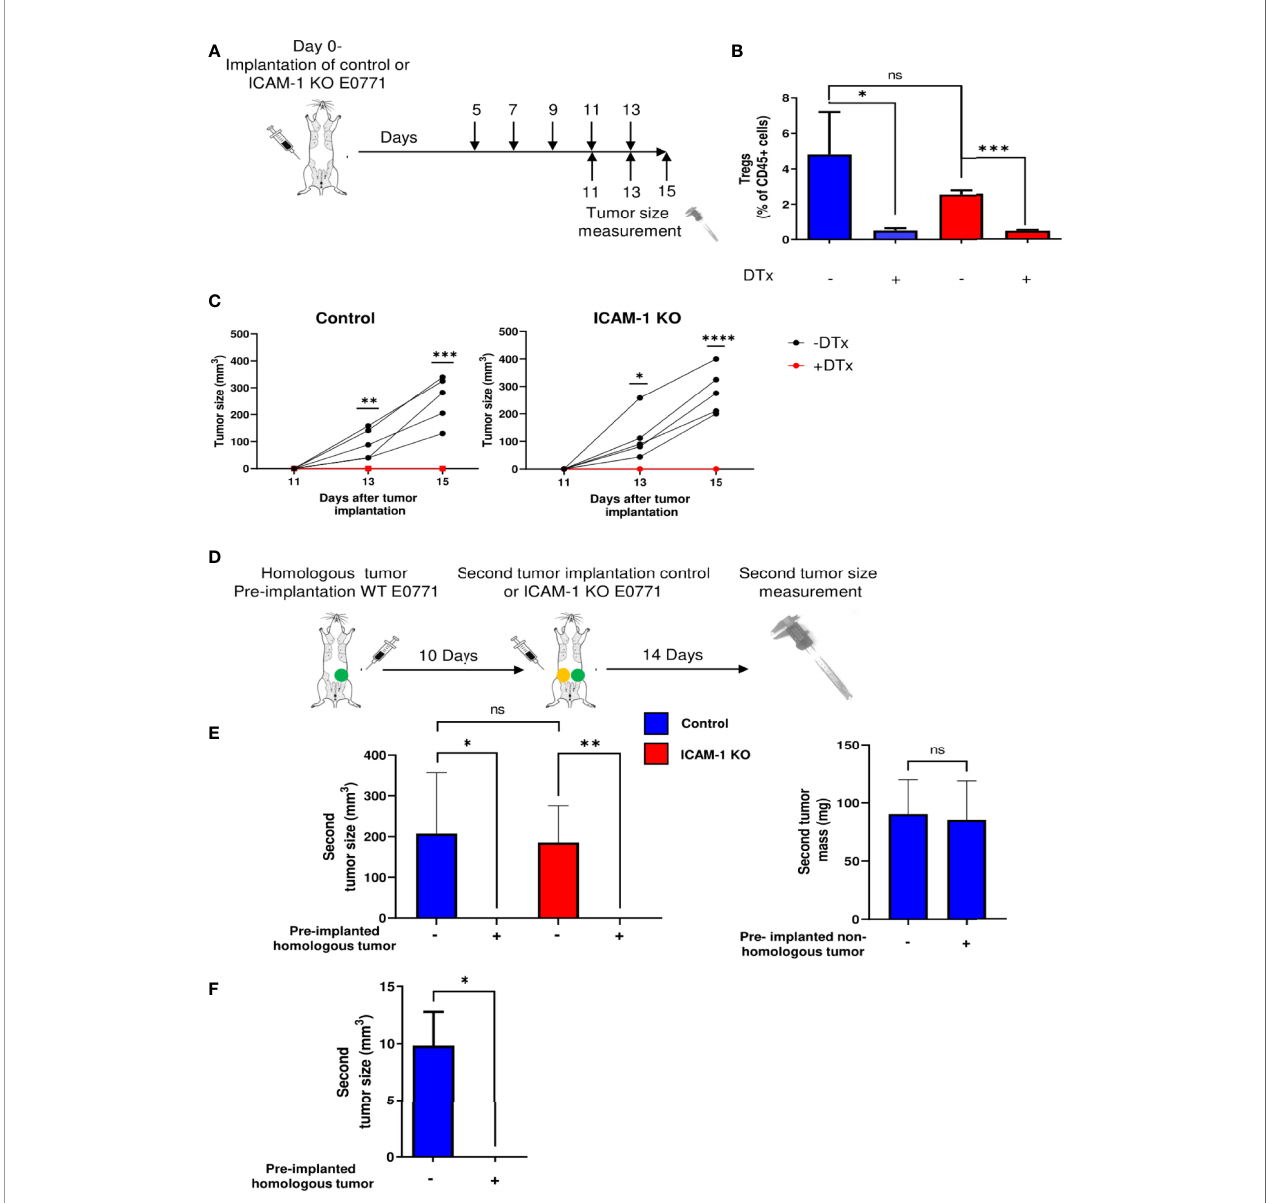
FIGURE 2 | Treg depletion and homologous tumor preimplantation eliminate primary E0771 tumors independently of ICAM-1 expression on the breast cancer cells. (A) A scheme depicting the experiment. 1 × 10 3 control or ICAM-1 KO E0771 cells were implanted in the mammary fat pad of C57BL/6 mice. DTx was injected every 2 days at the indicated time points, and the tumor size was measured on the indicated days. (B) Treg depletion by DTx injections was validated on day 17 in the TdLNs of mice implanted with control or the ICAM-1 KO E0771 cells. n=3. * p <0.05; *** p <0.0005; (C) The graphs depict the tumor size in the differently treated mice at the indicated time points. Black: untreated mice. Red: DTx-treated mice. n=5. * p <0.05; ** p <0.005; *** p <0.0005; **** p <0.0001. At all time points, no signi fi cant differences were found between control and ICAM-1 KO E0771 tumor sizes. (D) The experimental scheme: a WT E0771 tumor/Matrigel or a Matrigel suspension was pre-implanted in the left mammary fat pad (green- fi lled circle). Approximately 10 days later, a second primary tumor composed of either control or ICAM-1 KO E0771 cells (in Matrigel) was implanted in the right mammary fat pad (yellow- fi lled circle), and 14 days later, the size of the right tumor was measured . (E) The mean volume of the second primary tumors is depicted for the four experimental groups. n=5. The bars depict the average values ± range of either the tumor volume (left panel) or mass (right panel). * p <0.05; *** p <0.0005. (F) A primary B16-G-CSF tumor (1 × 10 3 cells) or control Matrigel was implanted in the